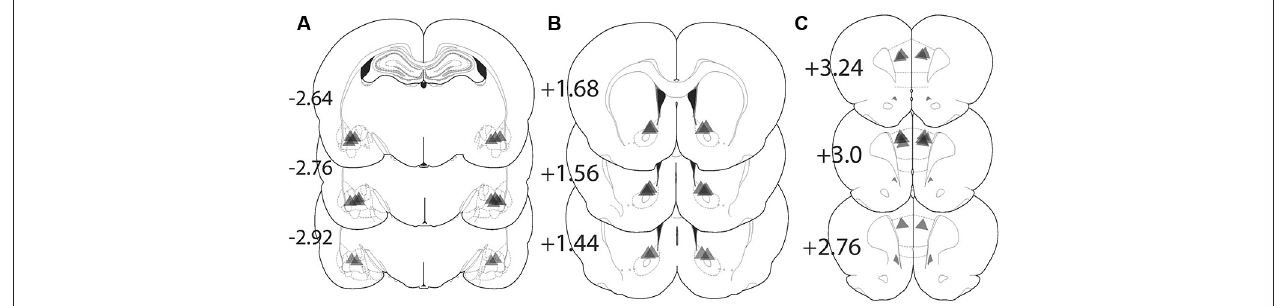
(A) Locations of fiber terminations in the BLA following BLA virus injection. (B) Locations of fiber optic termination in the NAcore following BLA virus injection. (C) Fiber optic terminations in the PL following BLA virus injection. The numbers refer to the location of the coronal section in millimeters